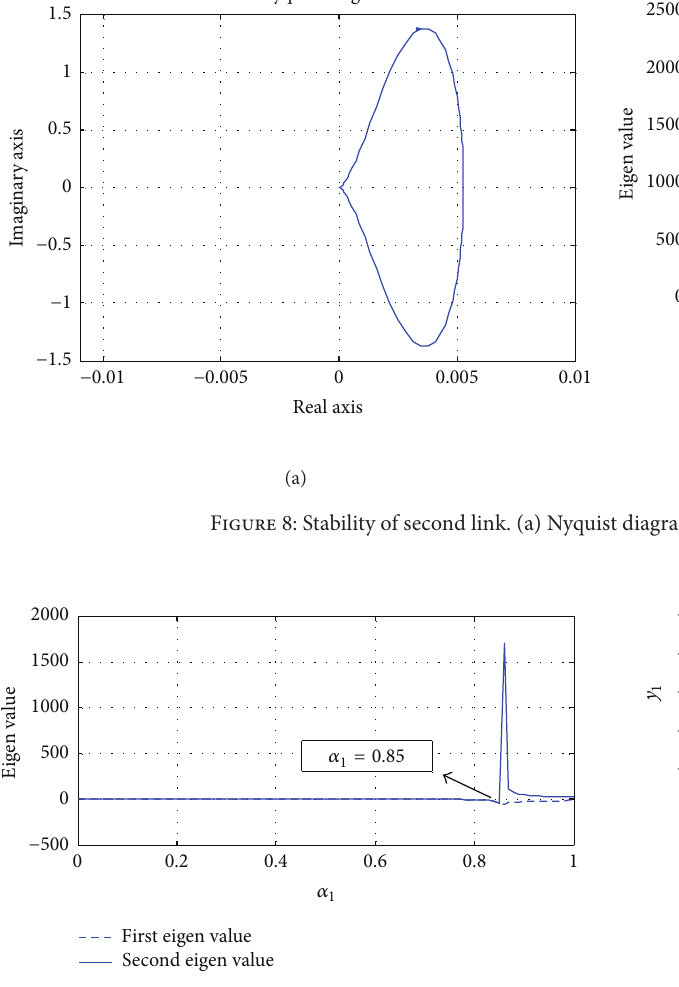
Figure 9: Stability of first link: eigenvalues versus 𝛼 1 [20].